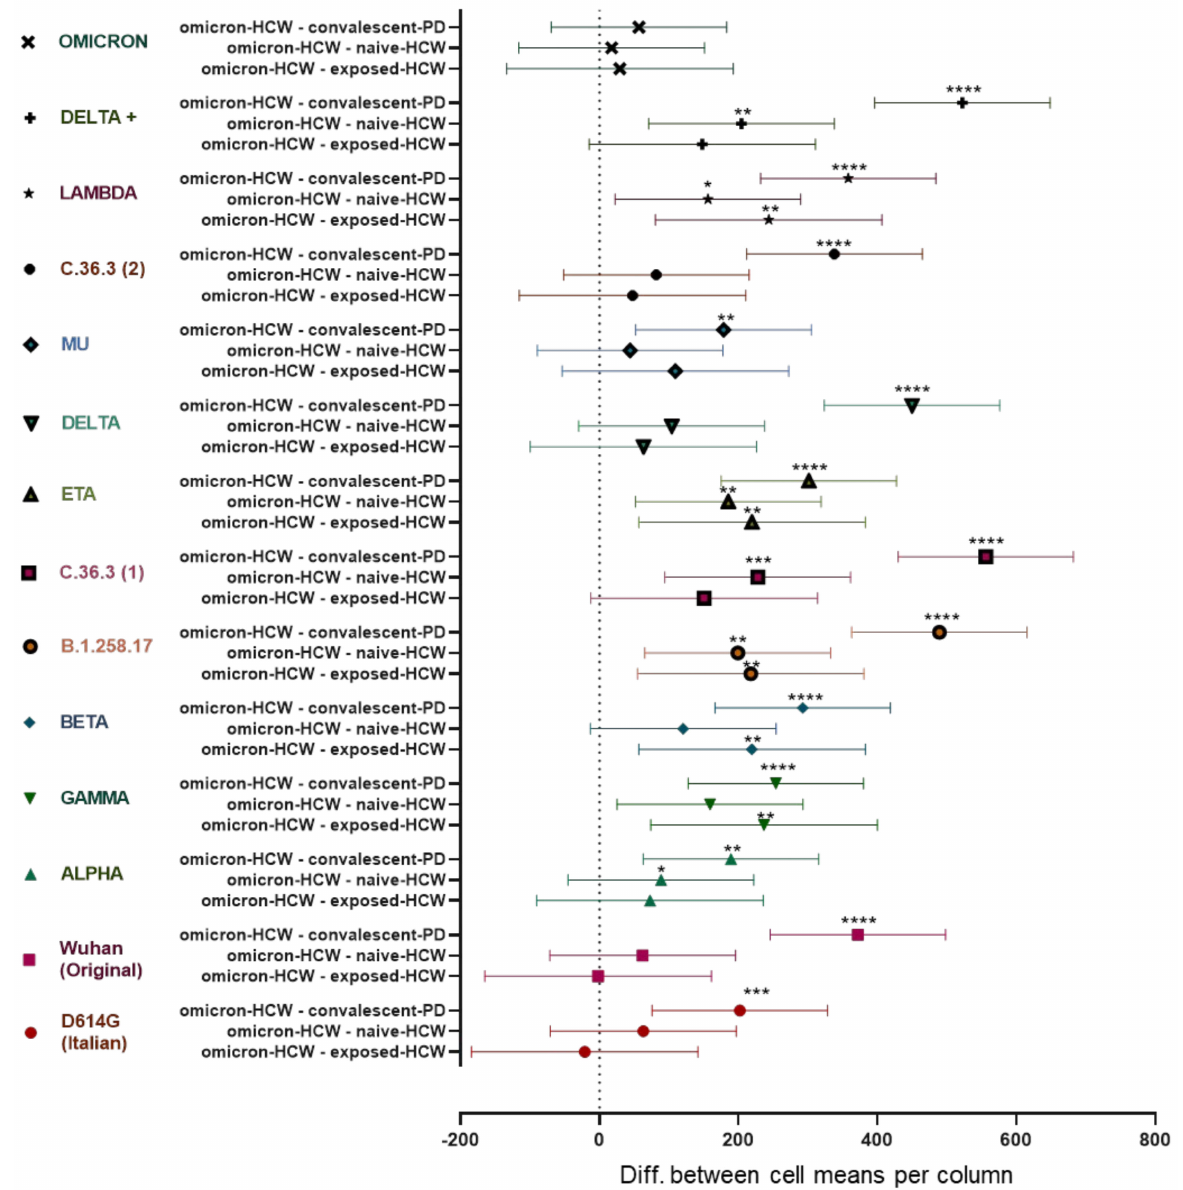
Figure 4. Data show the difference in means of the neutralizing titer (NT-Ab) against 14 different SARS-CoV-2 variants in naïve-HCW and exposed-HCW after 3 doses of BTN162b2 and in unvacci- nated convalescent-PD, in comparison to the fully vaccinated Omicron-HCW NT-Ab values. The more distant the values are from the origin line (0), the higher the difference between the paired popu- lations. **** p < 0.0001; *** p = 0.0001; ** p = 0.001; * p < 0.05. (Omicron-HCW—convalescent-PD: mean difference between Omicron-HCW and convalescent-PD groups; Omicron-HCW—naïve-HCW: mean difference between Omicron-HCW and naïve-HCW groups; Omicron-HCW—experienced-HCW: mean difference between Omicron-HCW and experienced-HCW